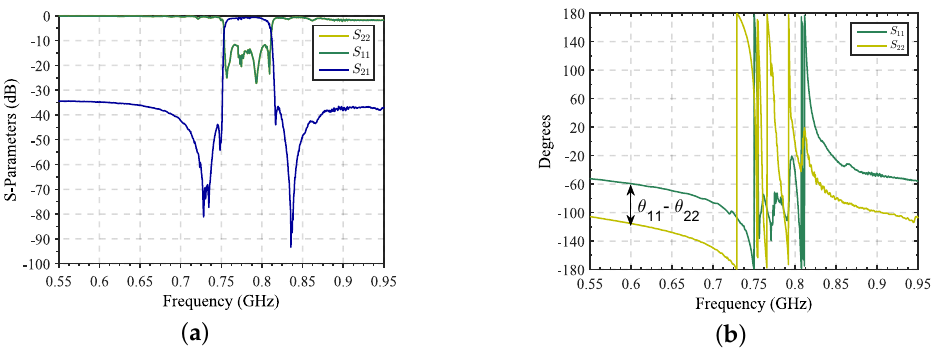
Figure 4. Magnitude ( a ) and phase ( b ) response of a 7th-order B28-Rx filter with a clearly differenti- ated input and output phases in the out-out-band